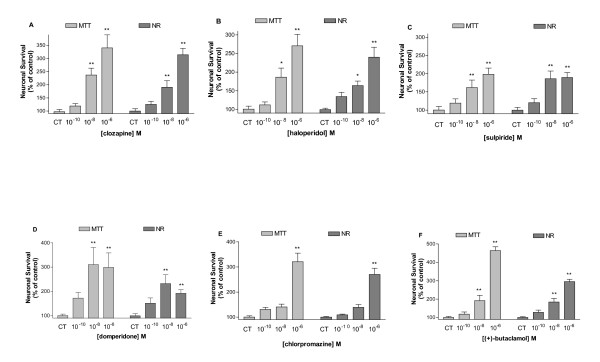
Effects of clozapine (A), haloperidol (B), (±)-sulpiride (C), domperidone (D), chlorpromazine (E) and (+)-butaclamol (F) against toxicity induced by growth medium deprivation in enriched hippocampal neuronal cultures. Neuronal survival is estimated using the MTT and neutral red (NR) colorimetric assays. Values represent mean ± SEM of at least three separate experiments, each performed in quadruplicate. *p < 0.05, **p < 0.01 compared to vehicle-treated groups.